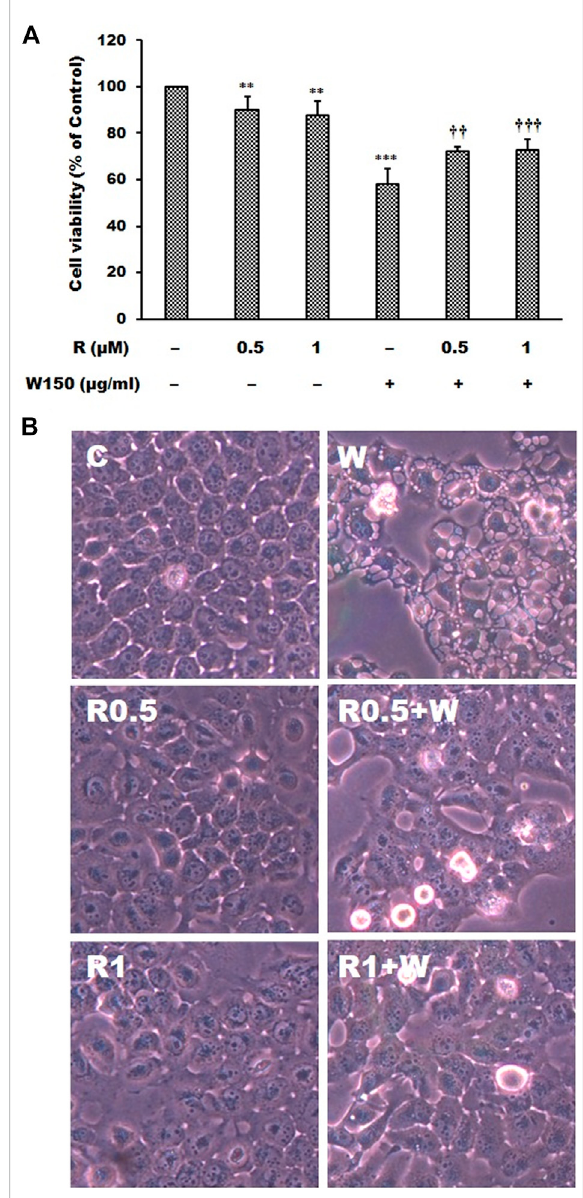
FIGURE 5 The effects of rapamycin on WGM extracts-induced cell death and membrane-enclosed vacuoles of Hep3B cells. Cells were pretreated with 0.5 or 1 μ M rapamycin (R) for 1 h and then treated with 0.1% DMSO or 150 μ g/ml WGM extracts (W) for 24 h. (A) The effects of rapamycin on WGM extracts-induced cell death of Hep3B cells. After treatment, the viable cells were measured by MTT assay. All determinations are expressed as the mean % control ±S.D. of duplicate from three independent experiments. ** p < 0.01, *** p < 0.001 compared to the control values. †† p < 0.01, ††† p < 0.001 compared to the WGM extracts alone. (B) The effects of rapamycin on WGM extracts-induced membrane-enclosedvacuolesofHep3Bcells.Aftertreatment,the cells were immediately photographed with an Olympus IX 73 phase-contrast microscope. All results are representative of three independent